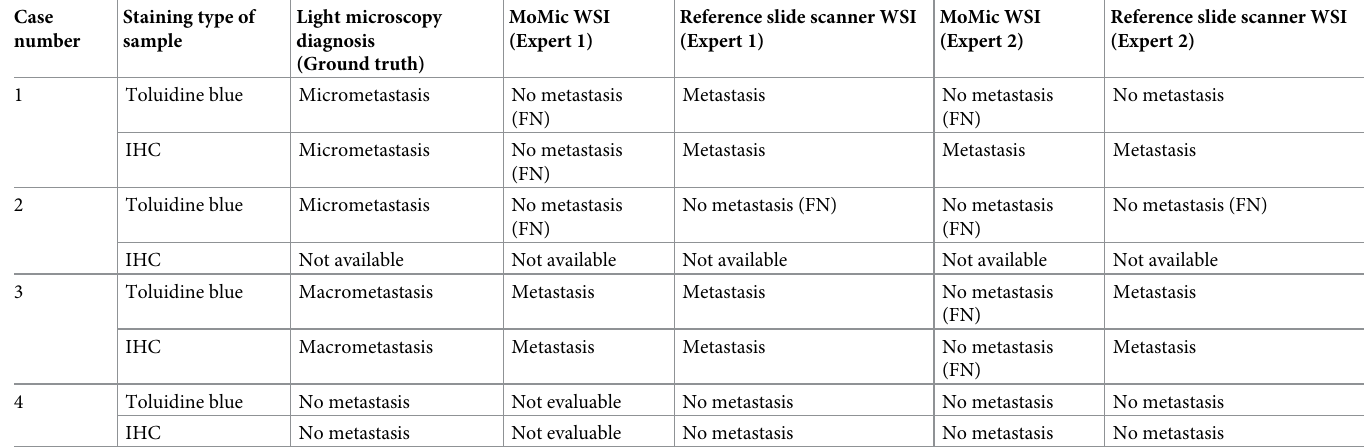
Table 3. Patient cases diagnosed incorrectly in analysis of WSIs from both scanners, compared to light microscopy.